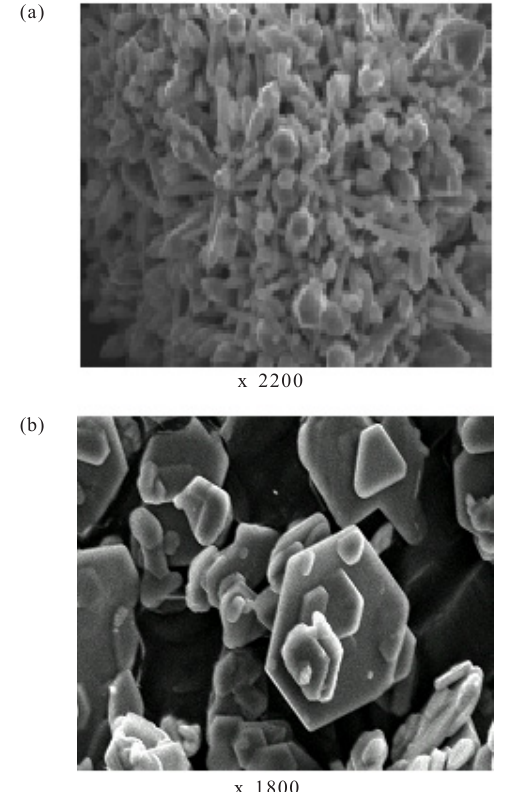
pH AT Figure 4. P released (%) from the hydrolysis reaction of H8-syn as a function of pH at equilibrium of NaCl solutions with concentrations of 0.01, 0.05 and 0.1 mol L -1 .